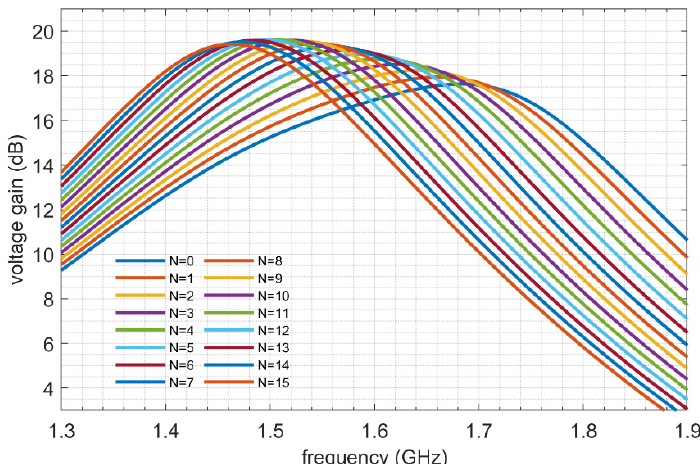
Figure 13. Differential voltage gain for different configurations of the switched capacitor bank C TR ( N = 0—no capacitor connected, N = 15 all capacitors connected).